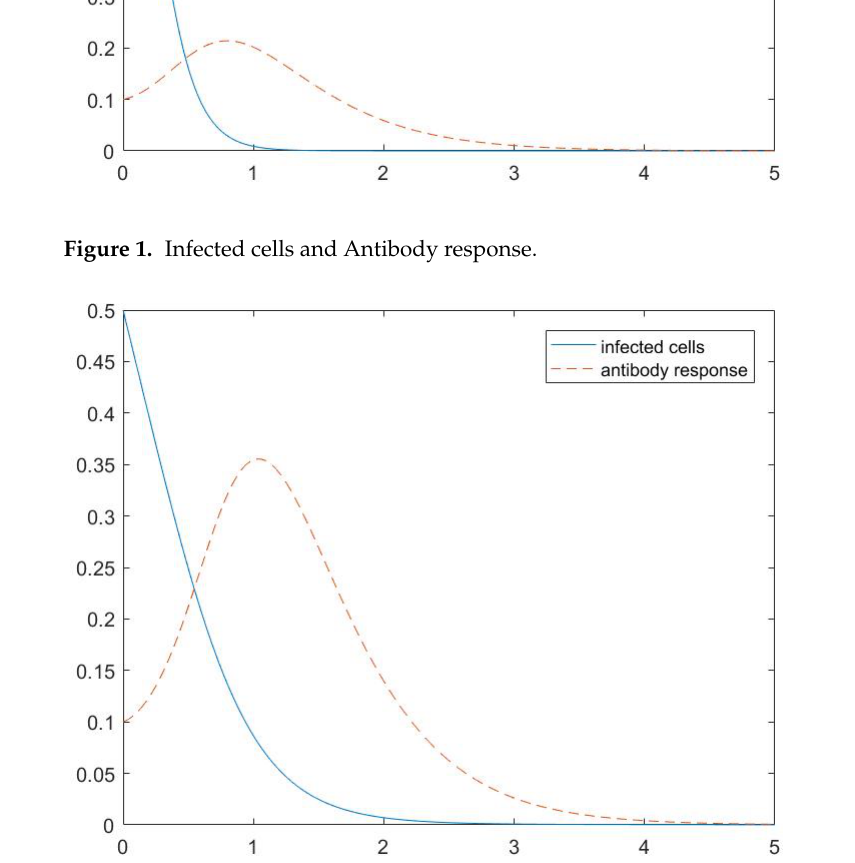
Figure 2. Infected cells and Antibody